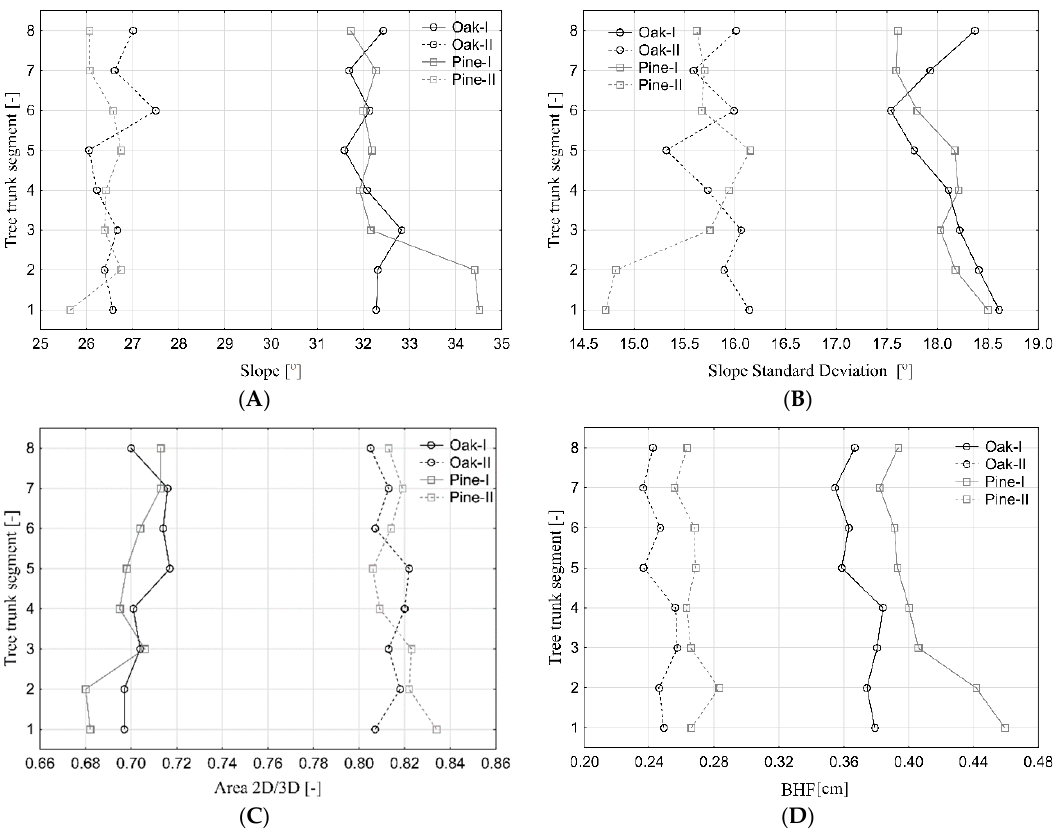
Figure 6. Changes in the slope ( A ); standard deviation of slope ( B ); 2D to 3D area ratio ( C ) and BHF ( D ) along the trunks of oak and pine trees.